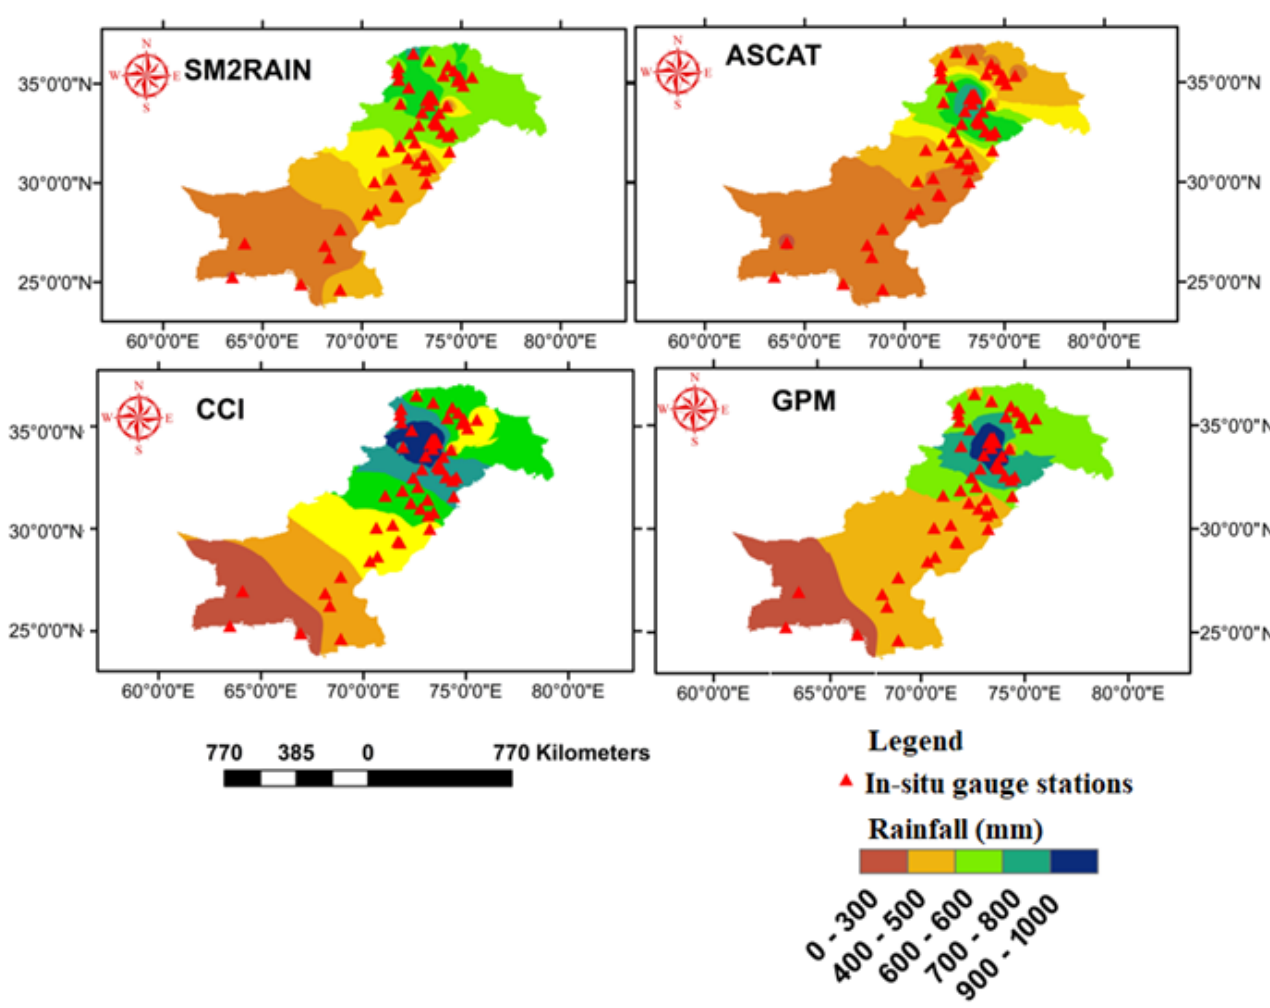
Figure 3. Comparison of spatial variability annual average precipitation of all SPPs.